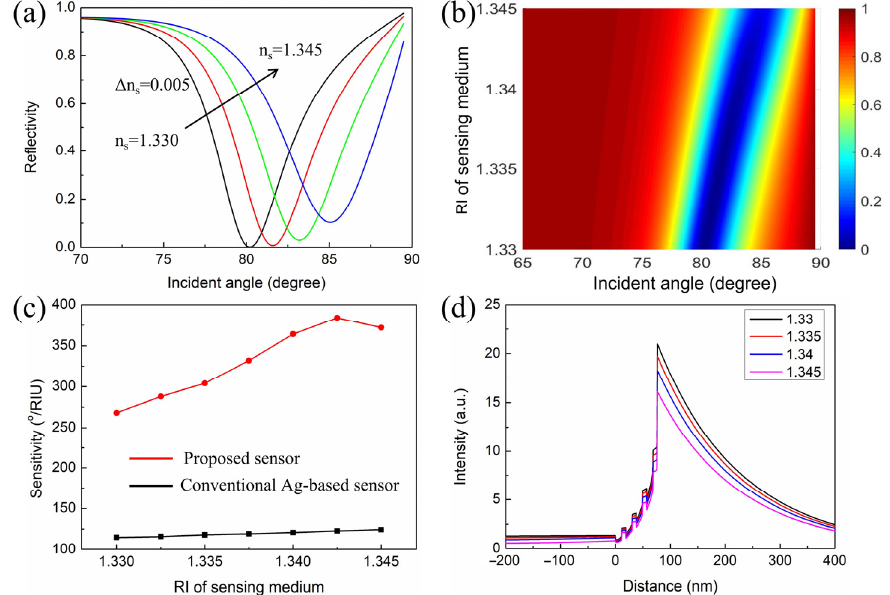
Figure 5. ( a ) The change in resonance curve with respect to the incident angle with n s = 1.33 to n s = 1.345. ( b ) Contour map of resonance curve as a function of incident angle and RI of the sensing medium. ( c ) Change in sensitivity with respect to the RI of the sensing medium for different sensors. ( d ) Electric field distributions of the proposed sensor with a change in IR of the sensing medium.